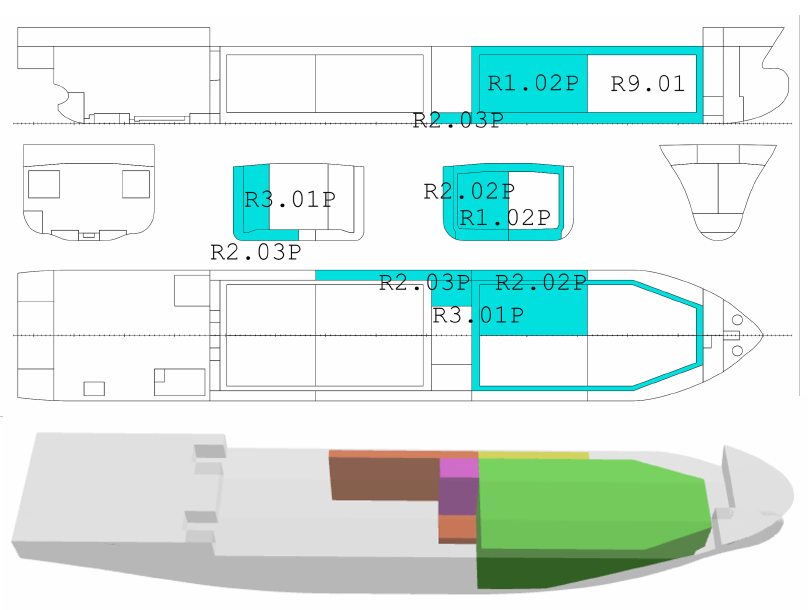
Figure 8. Illustration of damage case